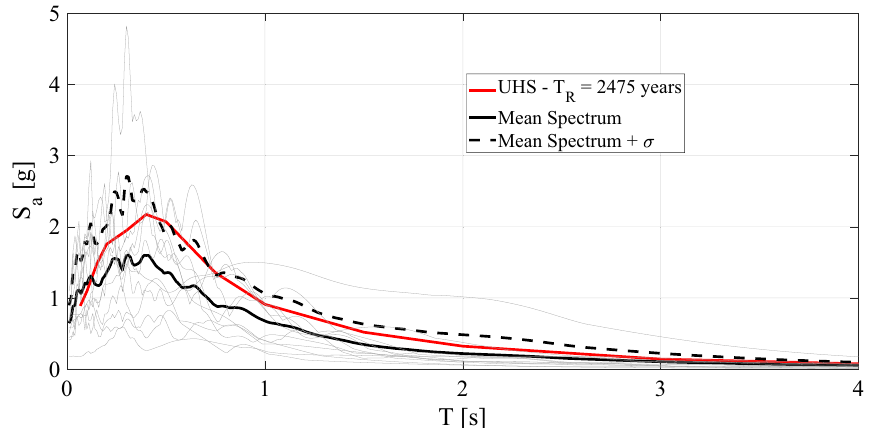
Figure 6. Response spectra of the selected accelerograms for SSEs; the UHS of Priolo Gargallo (Italy) is depicted in